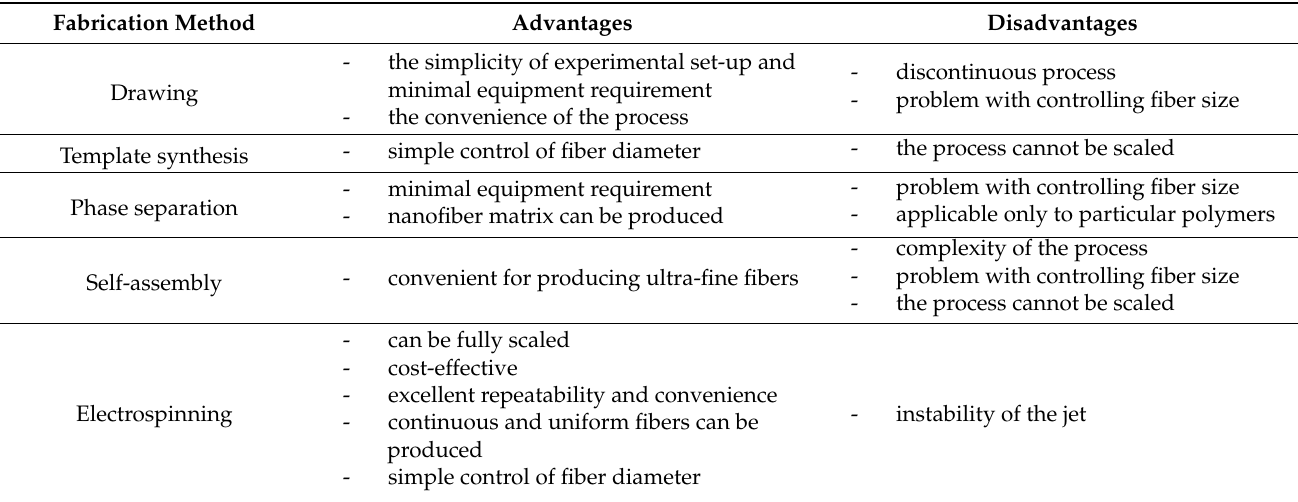
Table 1. Principal advantages and disadvantages of different methods of fabricating polymeric nanofibers.